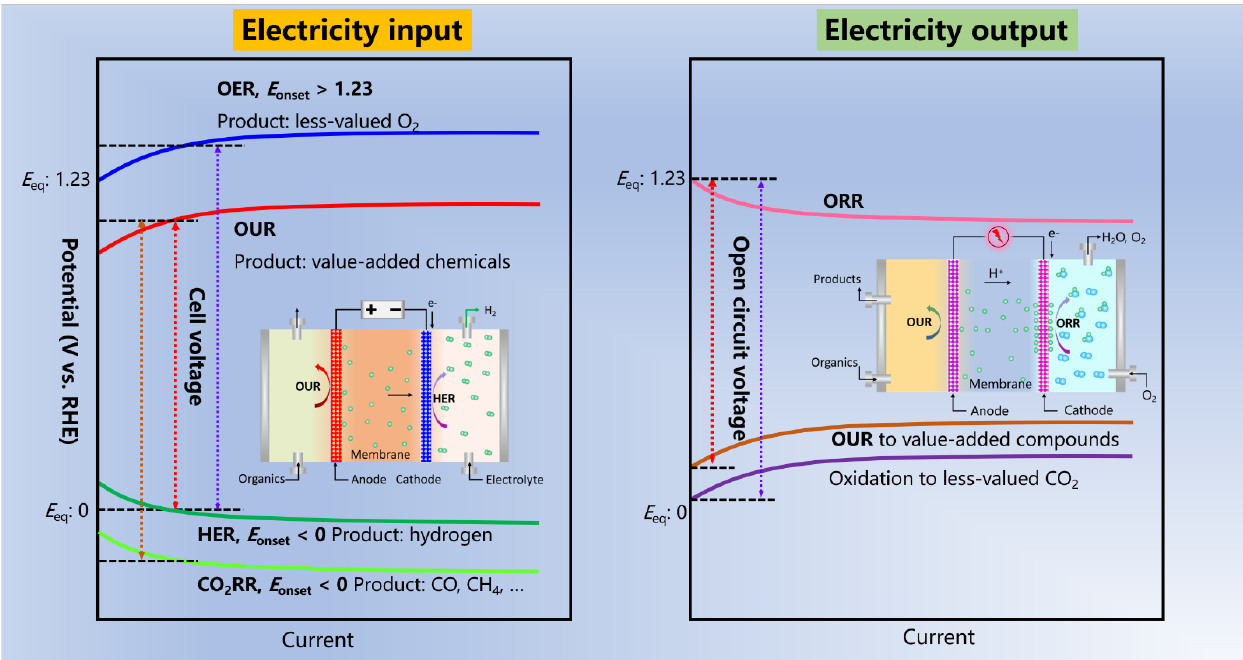
Scheme 1. Left: polarization curves of the electrochemical oxidation upgrading reaction (OUR) via the electricity-input mode to integrate with the hydrogen evolution reaction (OUR||HER) and carbon dioxide reduction reaction (OUR||CO 2 RR), and the comparison with conventional electrolysis. The inset is the configuration of a simplified single hybrid electrolyzer. Right: polarization curves of the electrochemically oxidative upgrading reaction (OUR) in a smart device (e.g., fuel cell) to output the electricity. The inset is the configuration of a single fuel cell with the OUR.